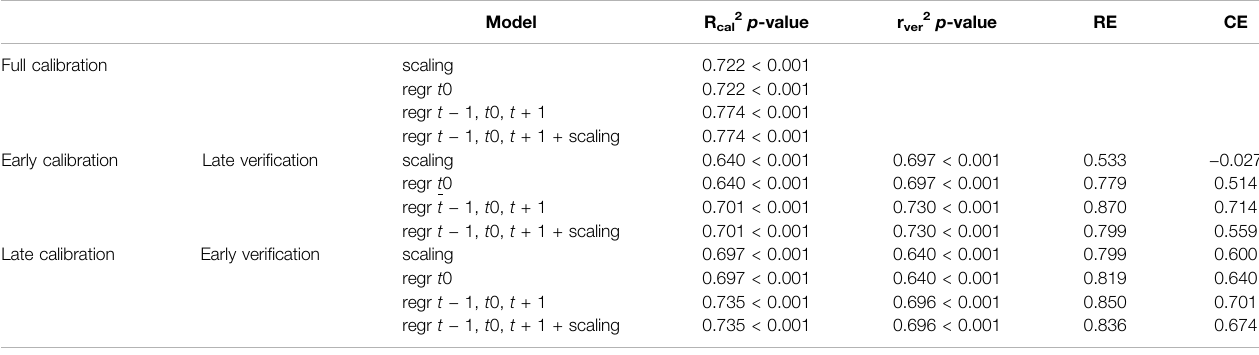
TABLE 1 | Calibration and veri fi cation statistics over the instrumental period. The MXD (maximum latewood density) record transformed into the temperature scale over the full,early, andlate calibration periods (1823 – 2010CE,1823 – 1916CE,and1917 – 2010CE,respectively) and theobtainedtemperature reconstructions veri fi edoverthe late and early veri fi cation periods [1917 – 2010 CE and 1823 – 1916 CE, respectively). The calibration/veri fi cation statistics include the coef fi cient of determination (R cal2 ) and varianceexplained(r ver2 ),givenwiththeirMonteCarlo – based p -values,andthereductionoferror(RE)andthecoef fi cientofef fi ciency(CE).Regressionmodels(regr)withone ( t 0;concurrentofdependentvalue)ormultipleindependentvariables( t − 1, t 0, t +1;predating,concurrent,andlaggingthedependentvalue)areincluded.Forregression- based reconstructions, the RE and CE statistics are positive for both sub-periods, indicating real skill in the reconstruction.